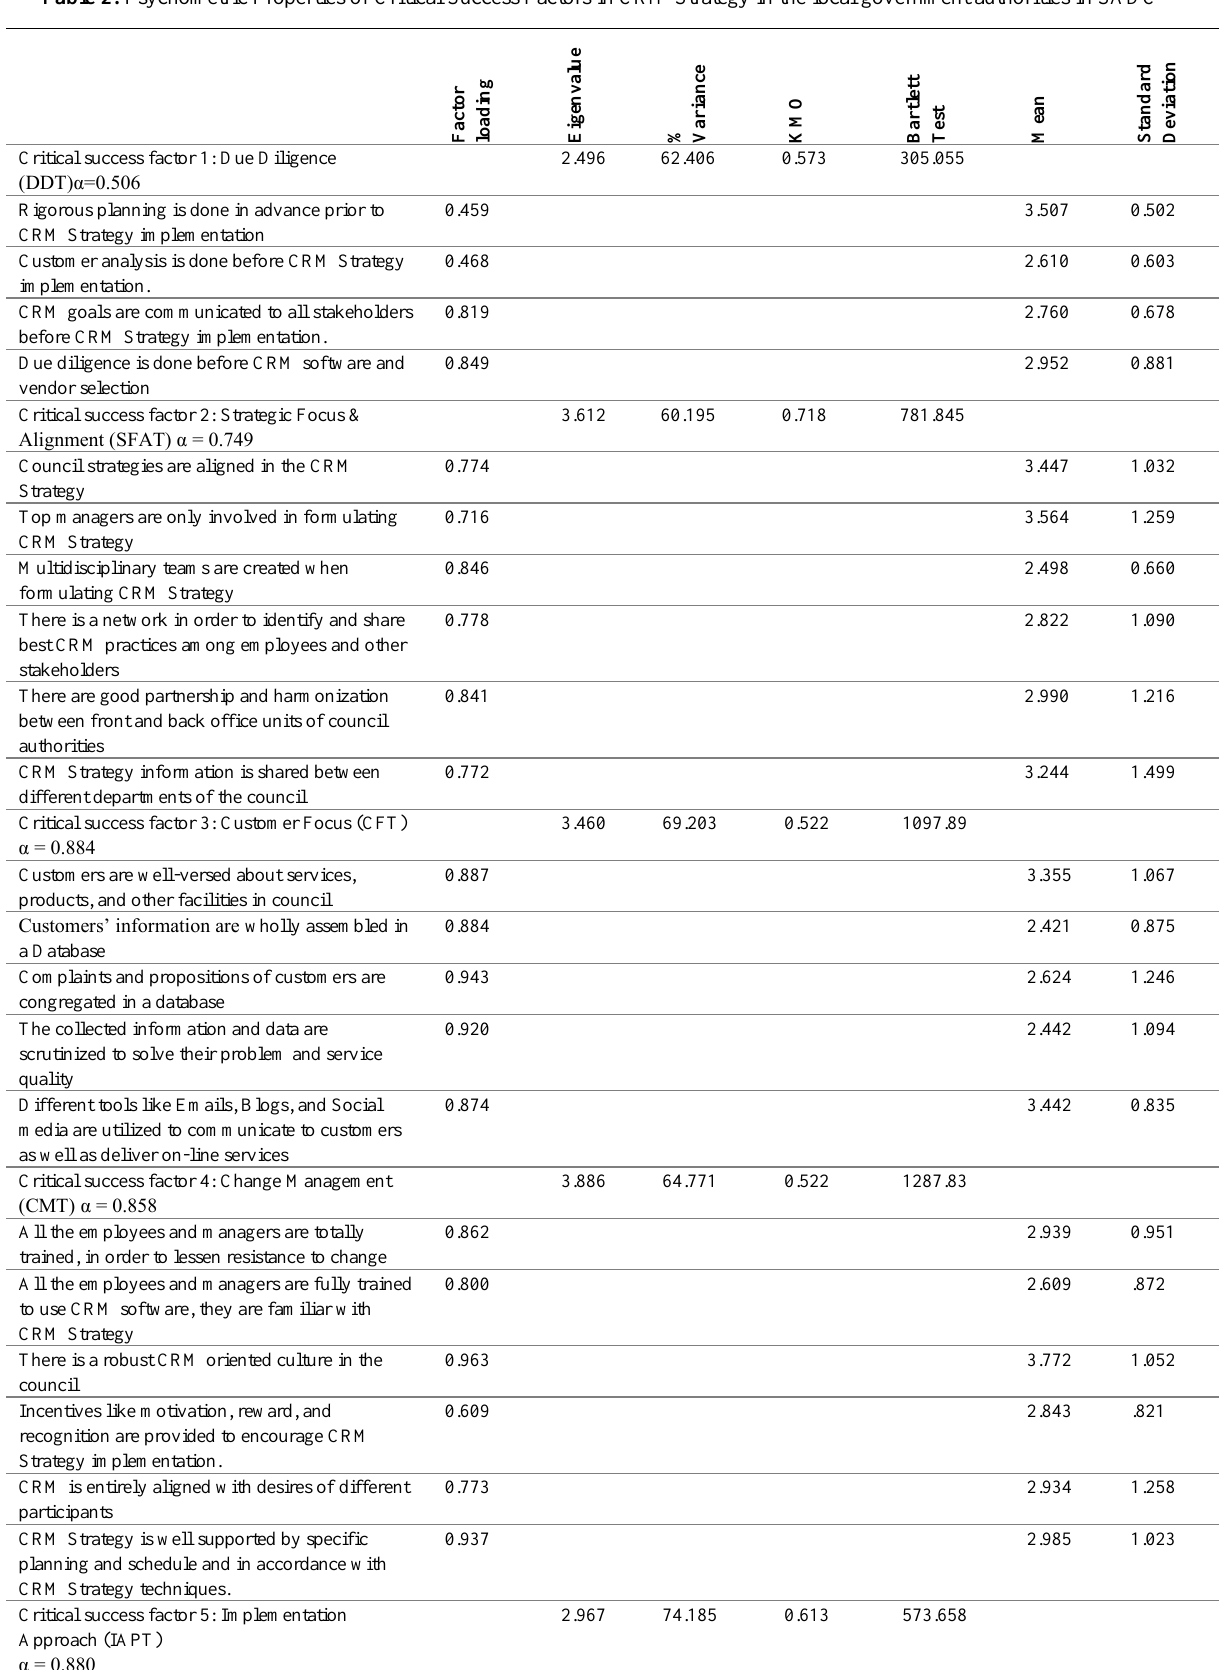
Table 2: Psychometric Properties of Critical Success Factors in CRM Strategy in the local government authorities in